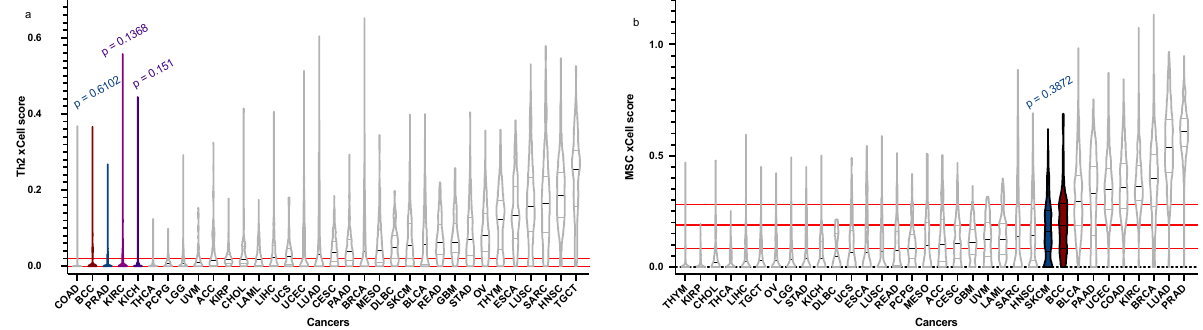
Figure 1. BCC vs. BCC “relatives”: xCell. In silico cell type enrichment scores obtained using xCell, comparing BCC (dark red) to other BCC “relatives” (white), with statistically similar cancers denoted (grey), with the top three in colour (dark blue, purple, violet) with their corresponding p -values above. Truncated violin plots of Th2 immune cytokine ( a ), and mesenchymal stem cells (MSCs) ( b ) are shown in order of ascending median. BCC median, 1st quartile, and 3rd quartile are delineated in red (where applicable).